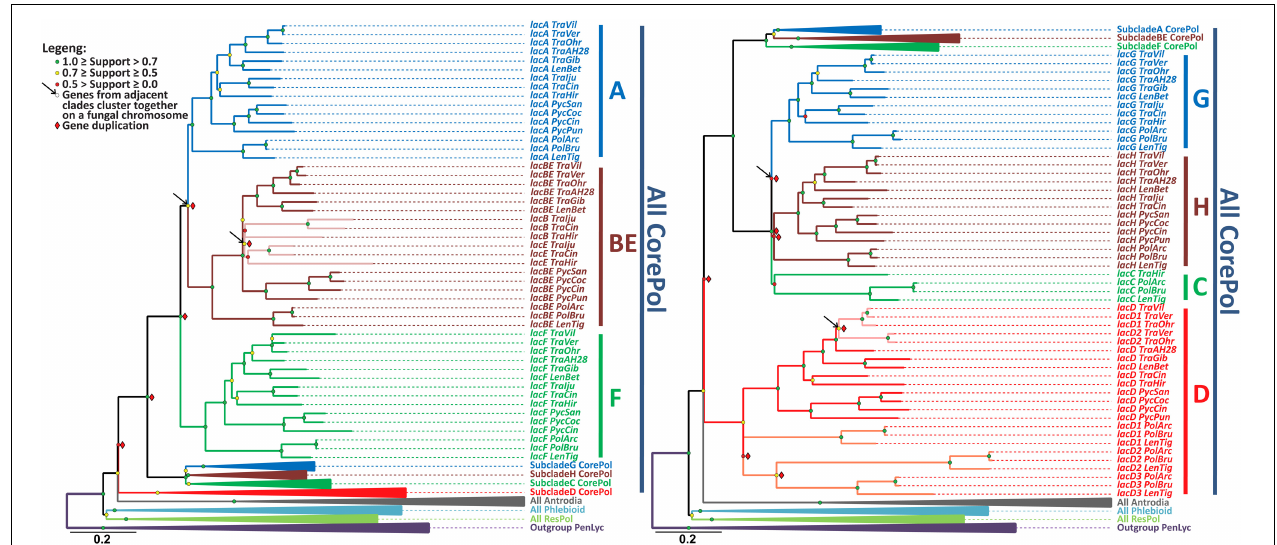
FIGURE 2 | The laccase gene-tree. The phylogenetic relationships of the laccase genes from the selected fungi of the Polyporales order inferred under the maximum likelihood criterion with a subsequent rearrangement of low supported branches by the synteny-aware gene-tree/species-tree most parsimonious reconciliation procedure. Bootstrap values at each node are color-coded, and indicators of the inferred gene duplications and synteny are placed near the corresponding nodes (see the legend). The clades that contains all laccase genes from the fungi of the core Polyporoid clade ( All CorePol ) is serially expanded (subclades A - H ). Expansion of the collapsed clades All Antrodia , All Phlebioid, and All ResPol contains all of the laccase genes from the fungi of the Antrodia, Phlebioid, and Residual Polyporoid clades, respectively, and can be found in Supplementary Figure S1 , along with the expanded Outgroup PenLyc clade containing the three laccase genes from P. lycii that were used as an outgroup. For the fungal species abbreviations, refer to Figure 1